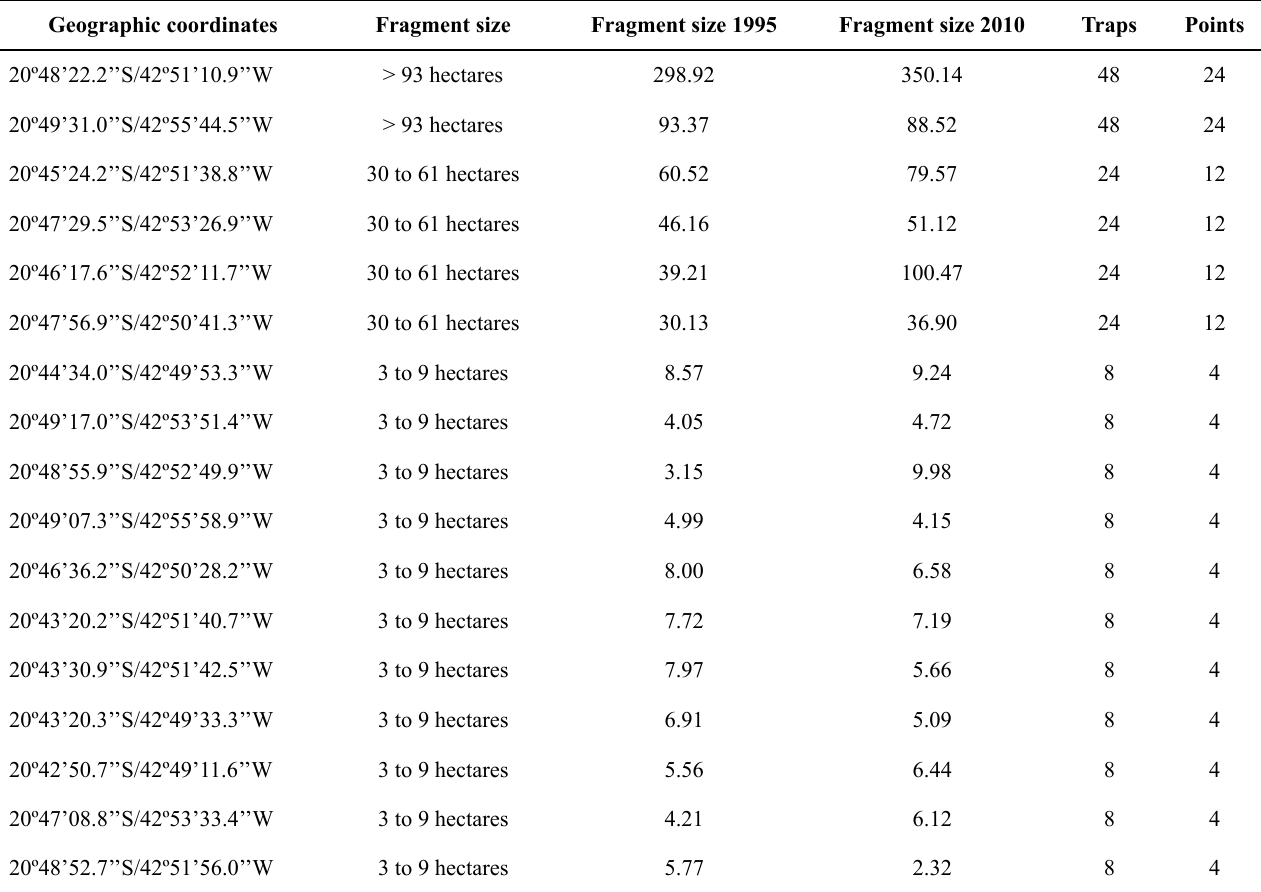
Table S2. Proportional size in hectare of fragments area, number of traps installed and points sampled in Viçosa, state of Minas Gerais, Brazil. Geographic